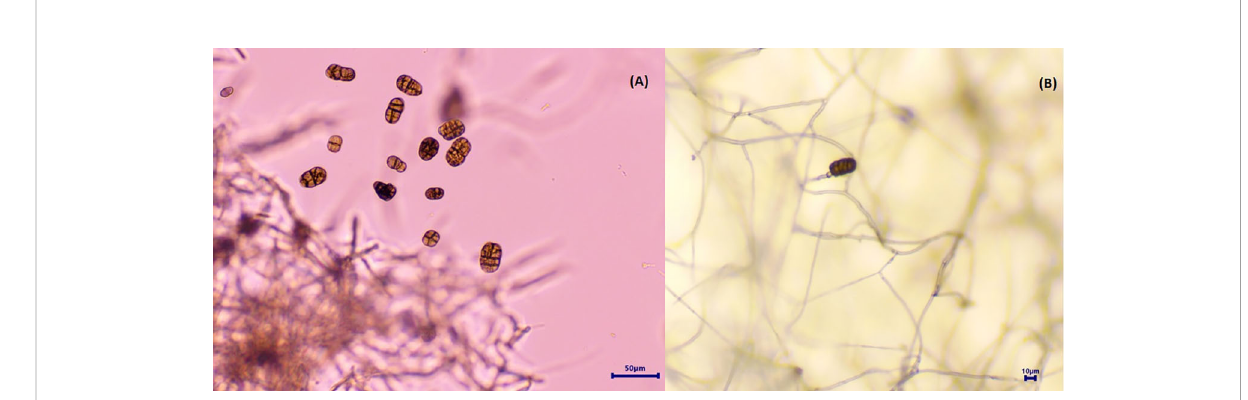
FIGURE 3 Spores of Stemphylium vesicarium on PDA media. (A) Conidia. (B) Conidia with